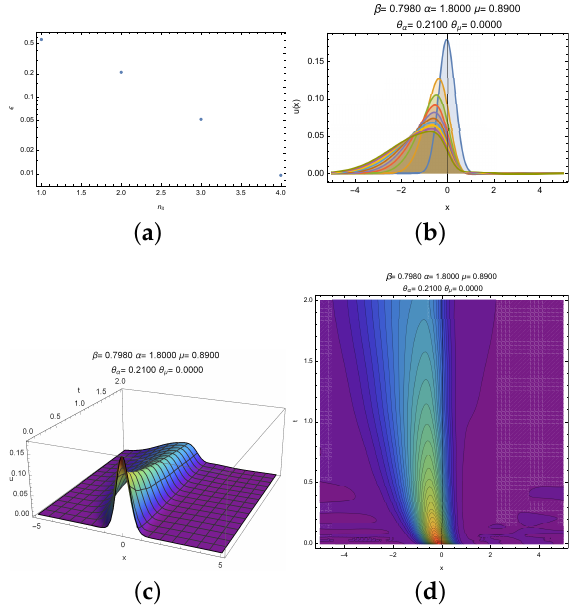
Figure 2. ( a ) Top left panel shows the convergence of the Neumann iteration toward a fixed error level (cid:101) ; ( b ) approximation of fFP for different times ( t ∈ { 0.1,0.3,0.5,0.7,0.9,1.1,1.3,1.5,1.7,1.9 } , top down) using a normalized Gaussian with amplitude b = 4; ( c ) 3D graph of the approximation; and ( d ) contour plot of the approximation. The fractional exponent are given on top of the graphs ( b ), ( c ), and ( d